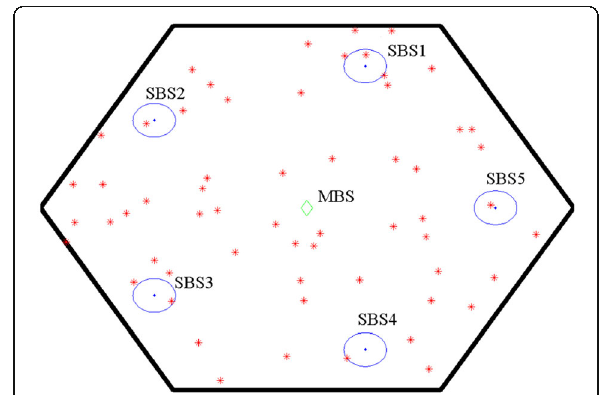
Fig. 5 Simulation model under different number of users